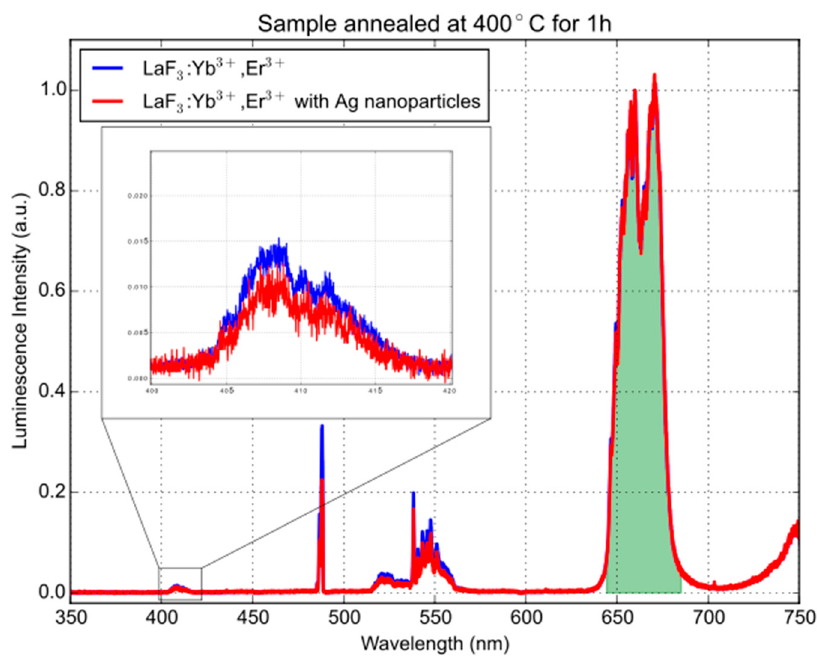
Figure 11. The up-conversion emission spectrum of the sample annealed at 400 °C excited by a 200 mW 980 nm diode laser. The intensity is normalized to the peak indicated by the green area.